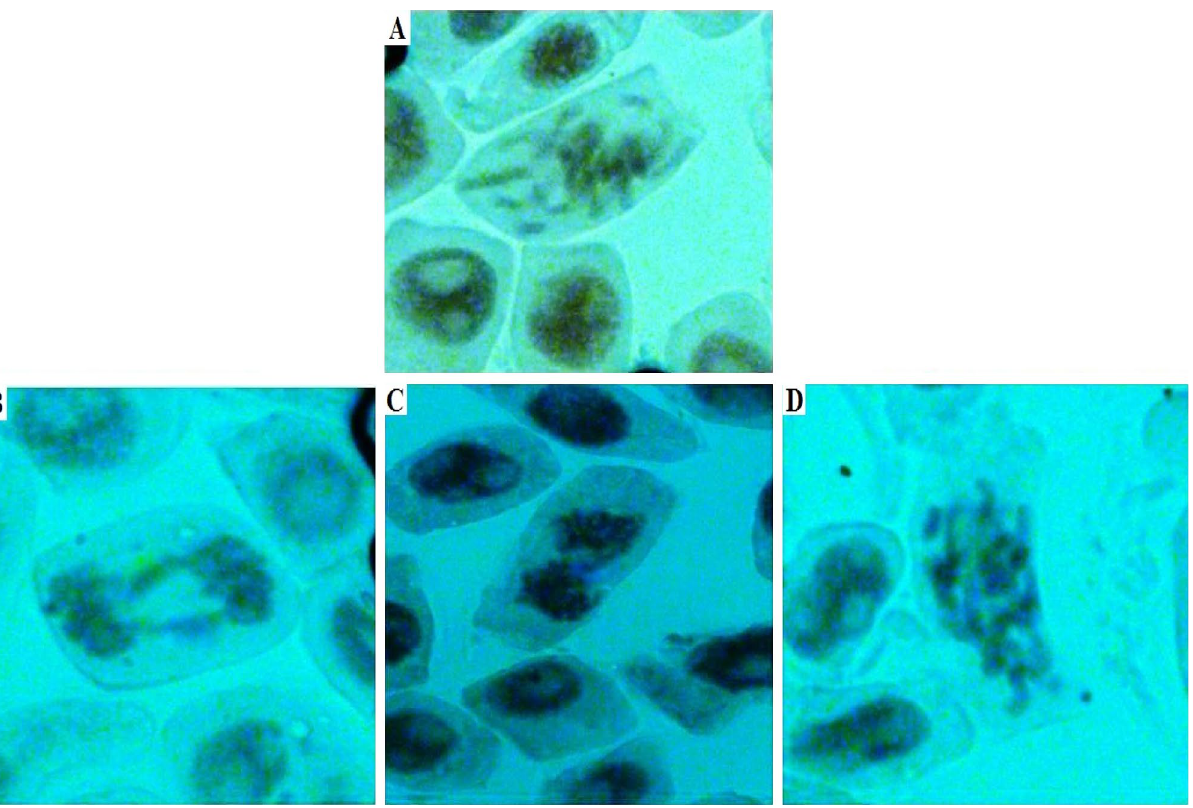
Figure 3. Chromosome aberrations ( Allium cepa assay, genotoxicity); ( A ) Chromosome break, ( B ) Chromosome bridge, ( C ) Chromosome clump and ( D ) Stickiness